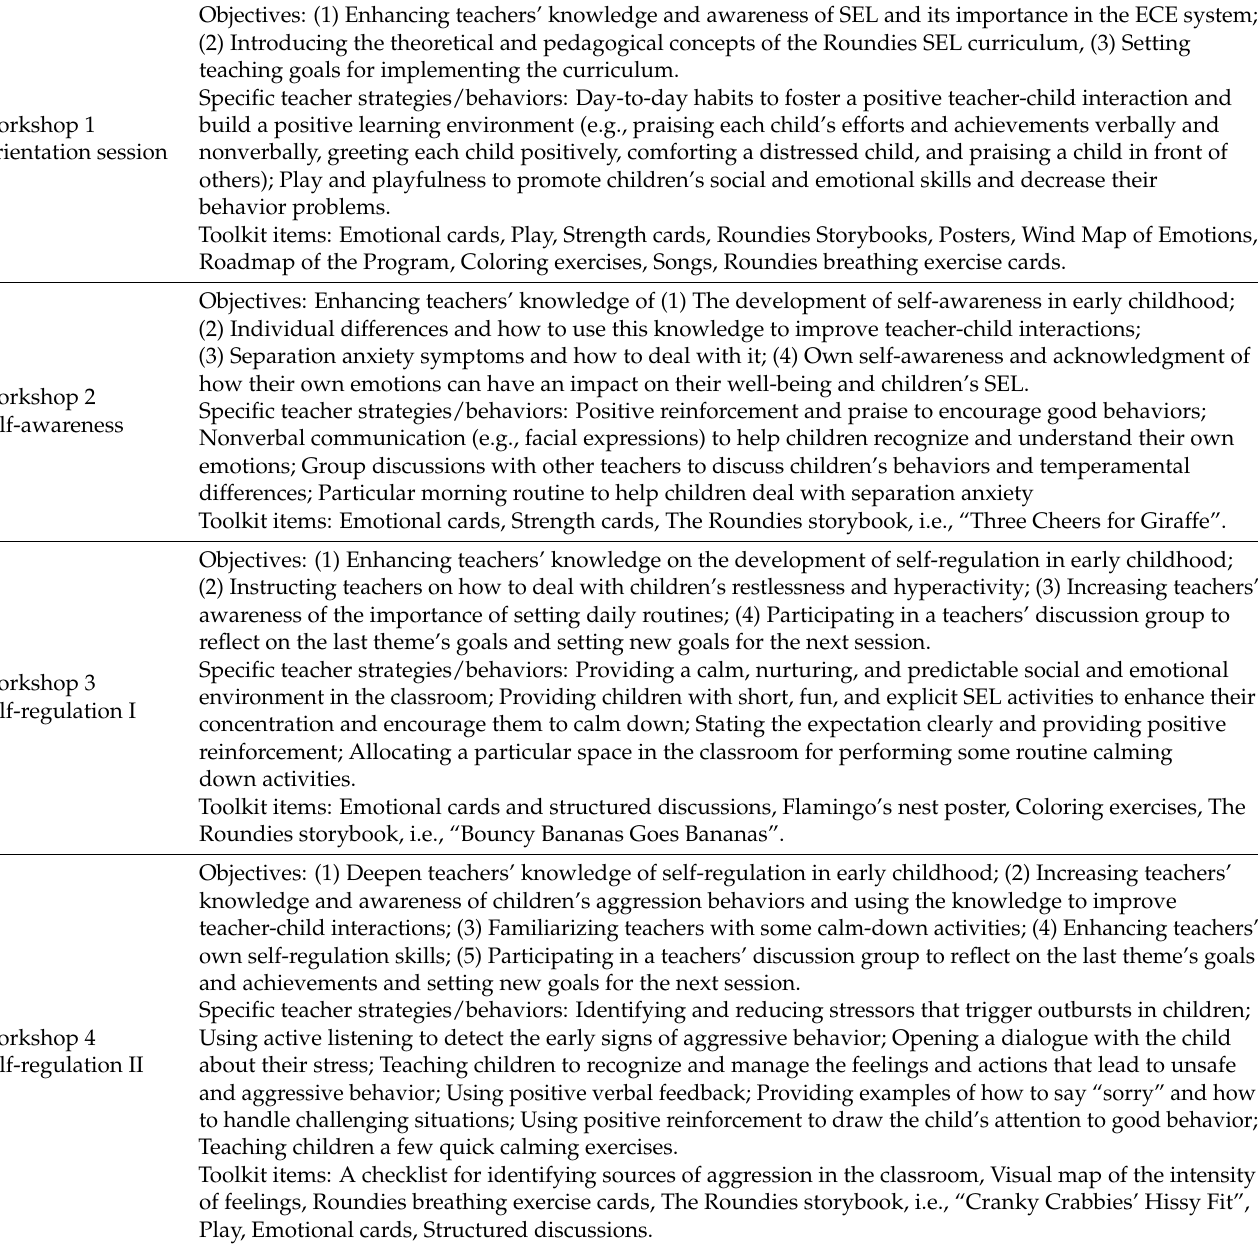
Table 3. Description of teacher training sessions, workshops’ objectives, skills, and toolkit